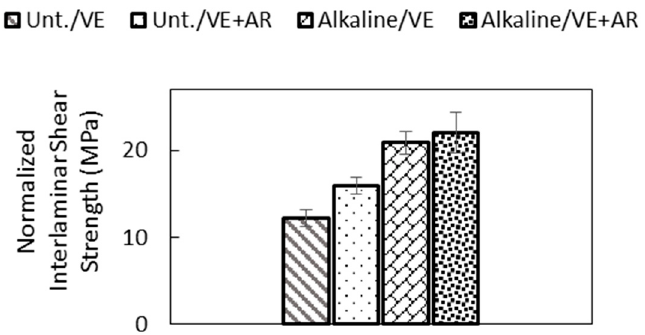
Figure 3. Normalized plots of Interlaminar shear strength for different composites.